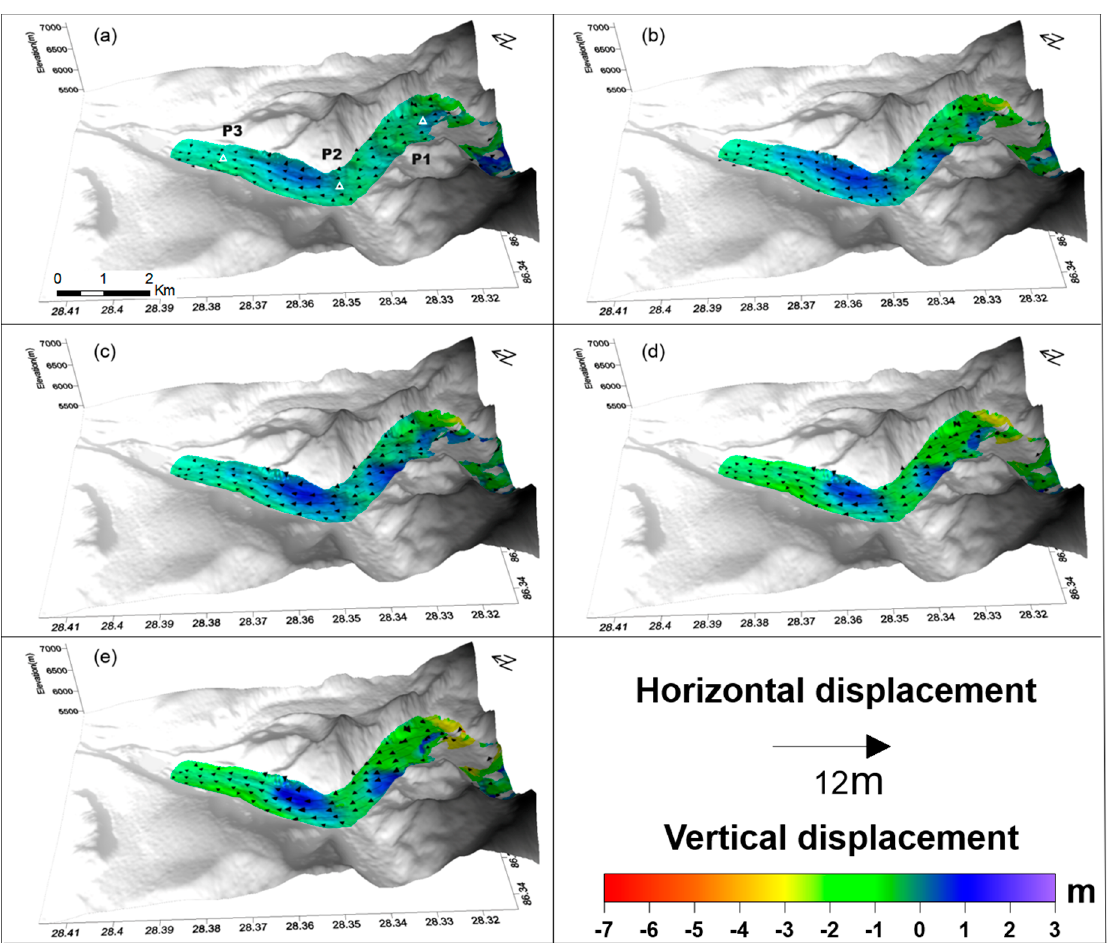
Figure 6. Time series of 3D displacement for glacier No.1 from 23 January to 25 December, 2018. Color represents the vertical displacement and arrows represent the horizontal displacement. ( a ) 20180123–